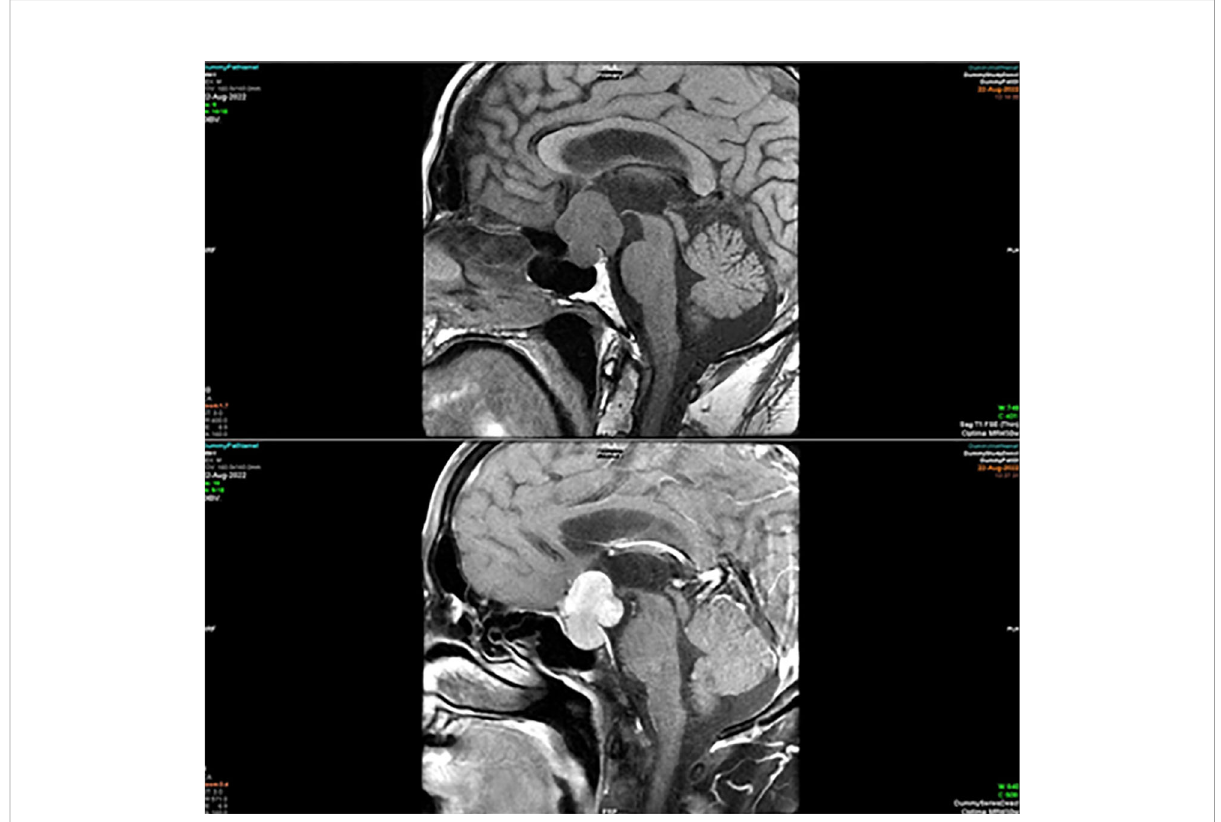
FIGURE 4 MRI T1 pre-contrast (top) and post-contrast (bottom) sagittal view of pituitary